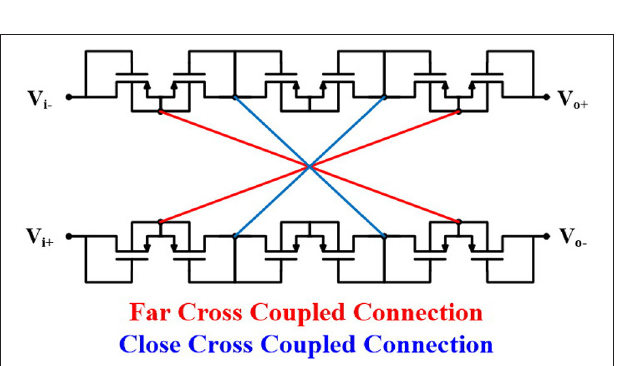
FIGURE 6 | Cross-coupled positive feedback